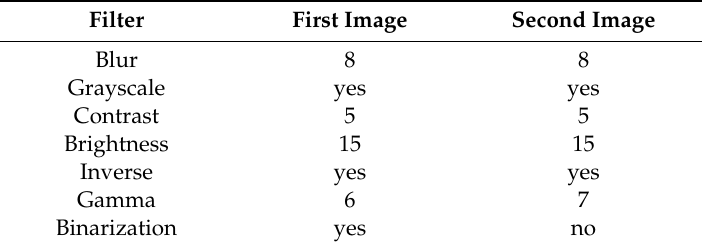
Table 1. The selected configuration for image processing.